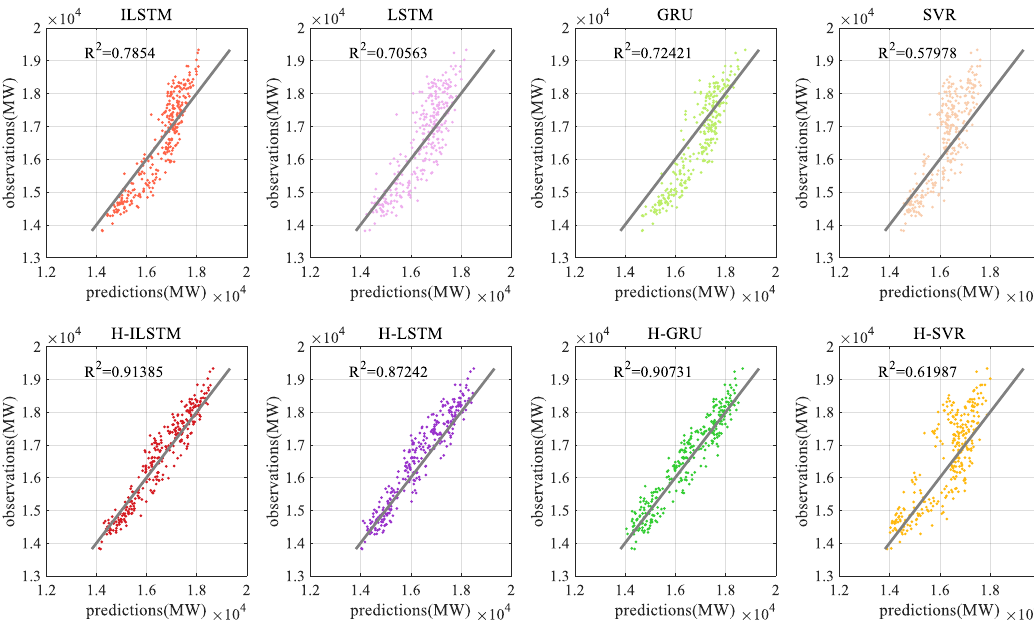
Figure 15. Coe ffi cient of determination by di ff erent methods for dataset